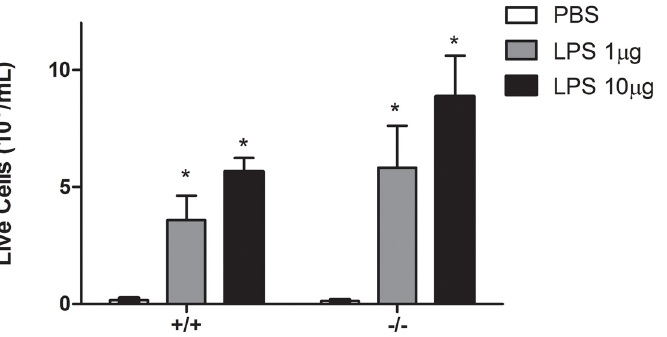
Fig 1. Dose response to LPS in Duoxa +/+ and Duoxa -/- mice. Leukocytes were collected from the airway compartment by BAL 24 hours after intratrachael instillation of LPS (1 μ g or 10 μ g). The number of live cells was determined by trypan blue exclusion. Live cell counts are displayed for PBS control (open box), 1 μ g LPS (gray box), or 10 μ g LPS for both Duoxa -/- (-/-) and Duoxa +/+ (+/+) mice. Data represent mean ± SEM from six animals in each group; * = p < 0.05 compared to PBS control.